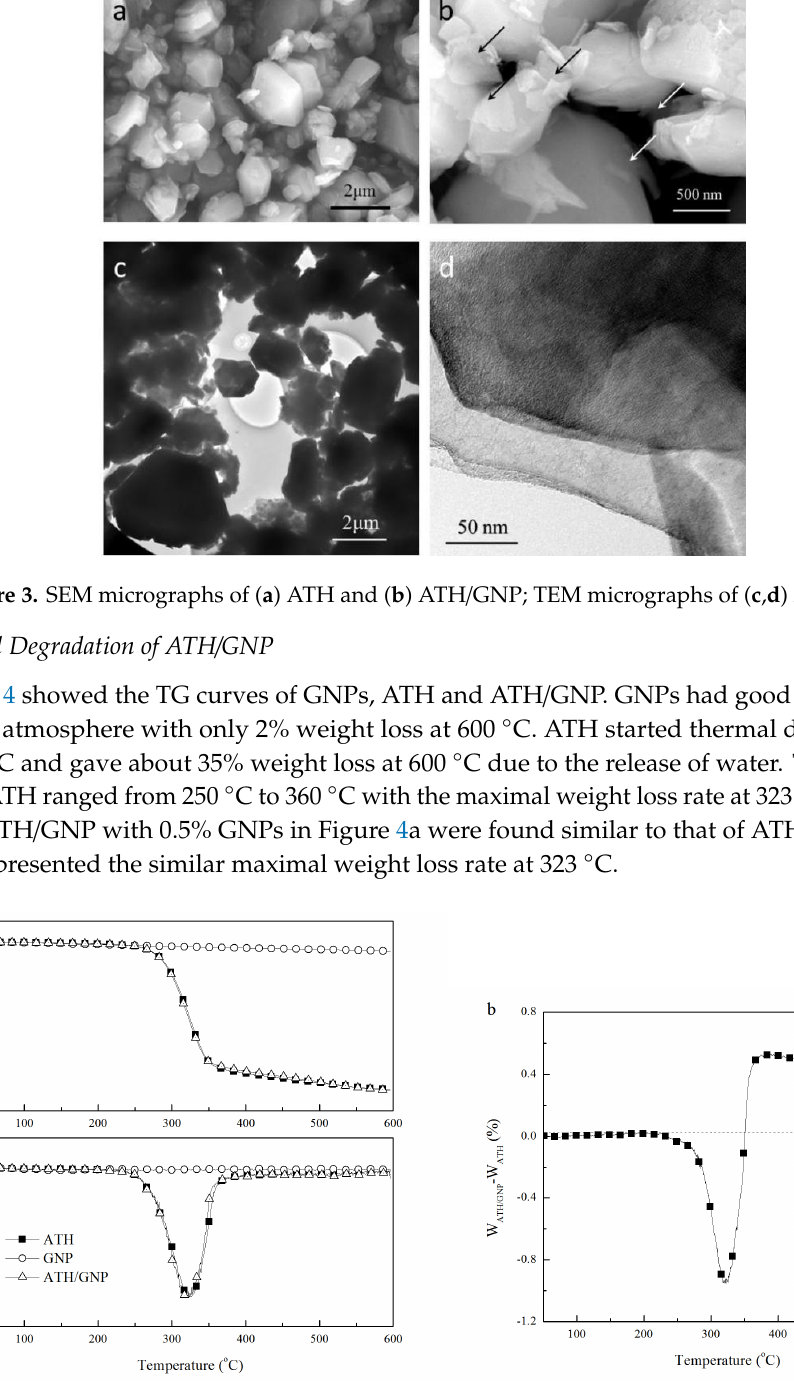
Figure 4. ( a ) TG curves of GNPs, ATH and ATH/GNP; ( b ) TG weight difference between ATH/GNP and ATH.